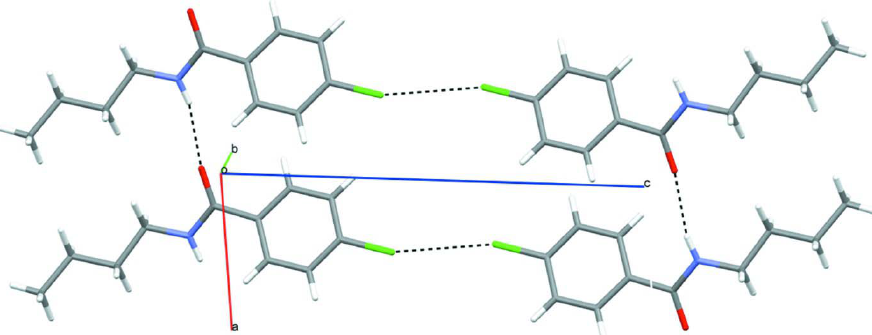
Figure 2 Sheets of molecules of I formed in the ac plane by N—H···O hydrogen bonds and Cl···Cl